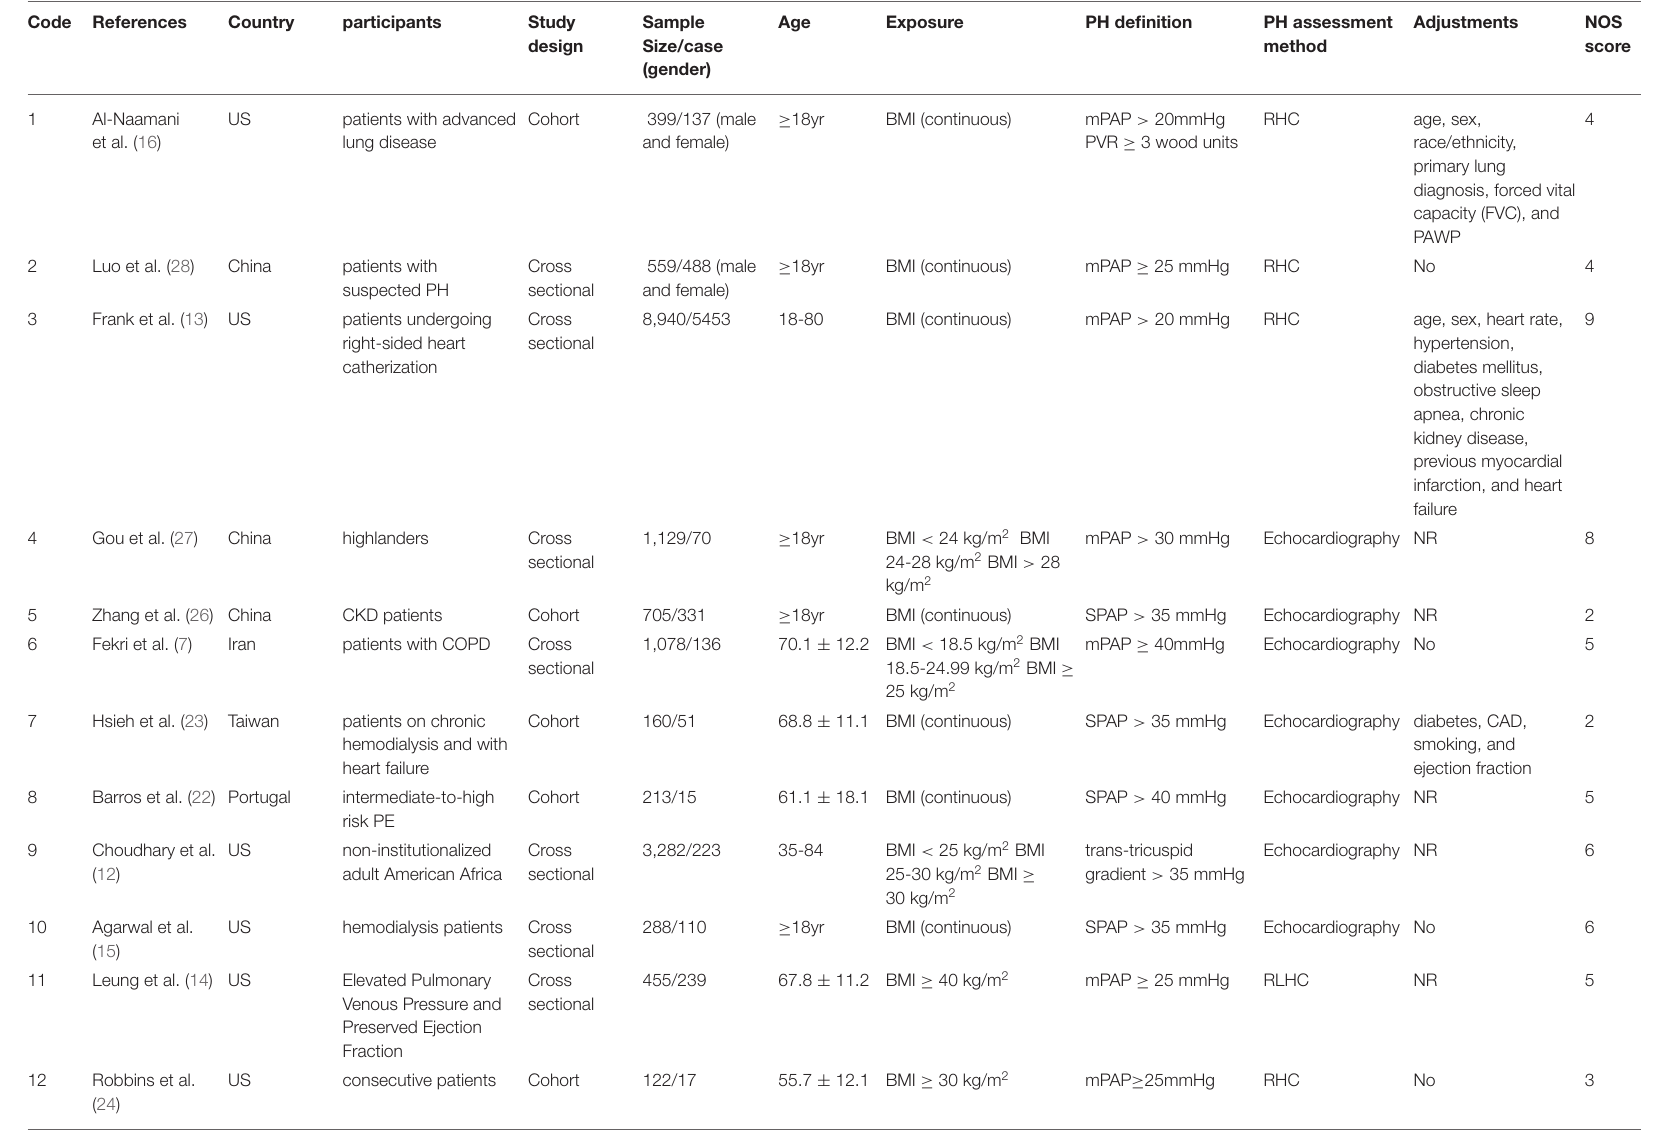
TABLE 1 | Characteristics of observational studies eligible in the systematic review and